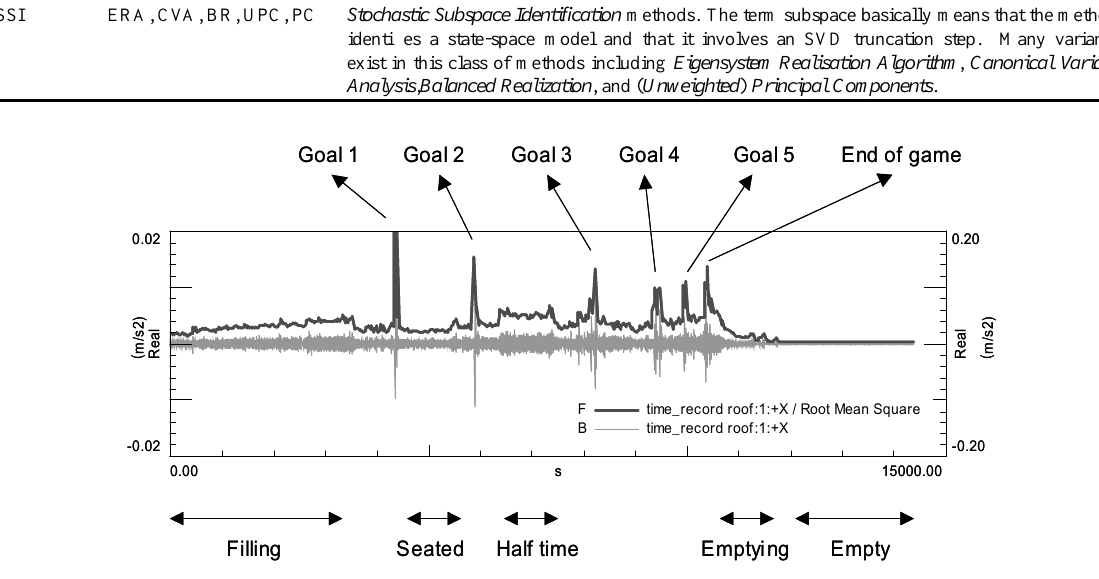
Fig. 5. Typical acceleration time history and “sliding” RMS value with an indication of the events during the game.